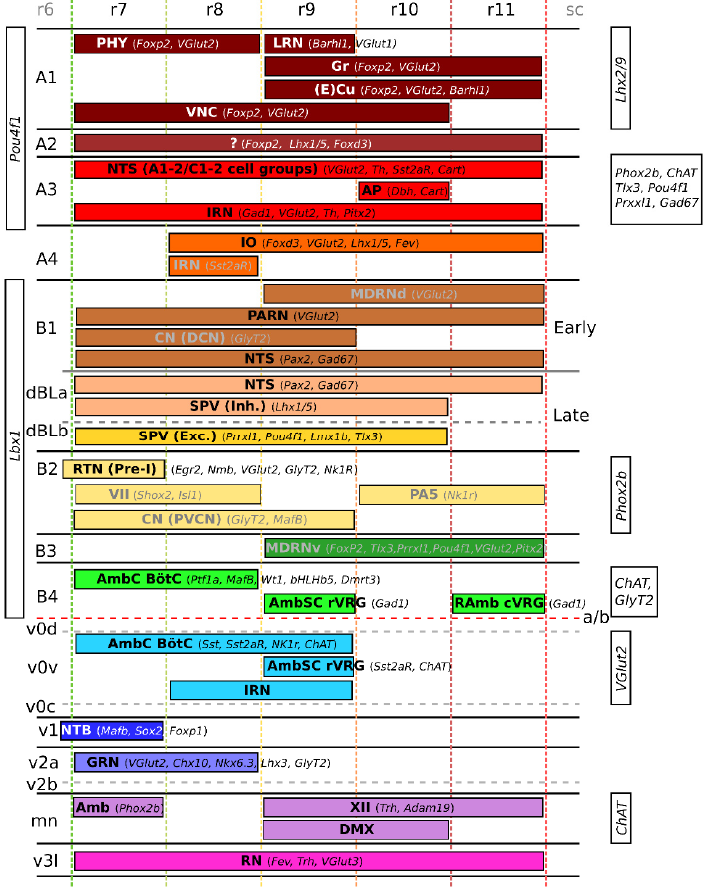
Figure 3. Location and gene expression of medullary nuclei in the adult medulla oblongata. Overview of the location and gene expression of medullary nuclei present in the adult medulla. From each progenitor domain, neurons are formed that belong to specific medullary nuclei in the adult medulla. Colors of the nuclei correspond to the originating progenitor domain. Neurons derived from the dA2 progenitor domain are characterized by the expression of Foxp2, Lhx1 / 5, and Foxd3 , but which nuclei these neurons become part of is currently undefined, as depicted by the ? symbol. Neurons from different nuclei express a unique set of genes, which are highly related to the function of these neurons in the nucleus. Some genes are expressed in neurons of multiple nuclei, shown in the white boxes. Interestingly, some nuclei appear to be build ‐ up from neurons derived from one progenitor domain (e.g., Gr, VNC, SPV, GRN), whereas other nuclei contain neurons derived from multiple progenitor domains (e.g., CN, Amb). The origin of some nuclei is hypothesized and not conclusively shown (depicted in grey).